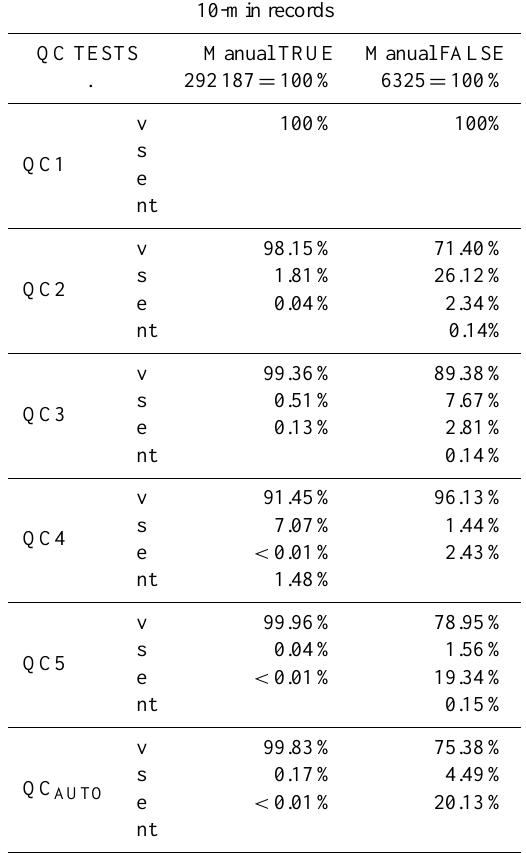
Table 3. Quantitative evaluation of the different tests involved in the automated QC of the 10-min soil/grass temperatures records (QC1 = physical limits test, QC2 = Min–Max range test, QC3 = spike/step − persistence test, QC4 = spatial horizontal test and QC5 = probable range test). The evaluation is performed over the full month of November 2014. A total of 298512 (100%) 10-min records including all soil/grass temperature parameters recorded within the RMI AWS network have been analyzed (v = valid, s = suspect, e = erroneous, and nt=no check).